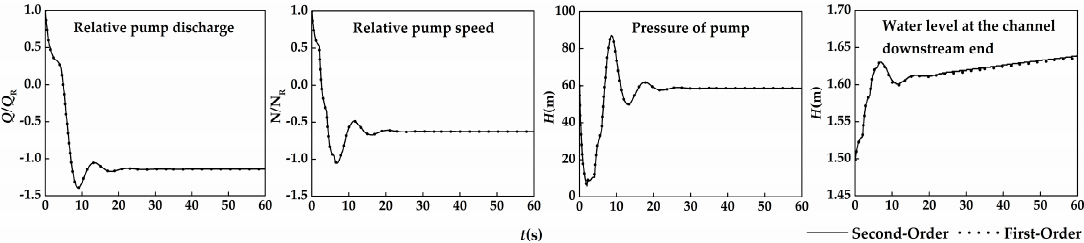
Figure 8. History curves of pump and channel parameters of First-order and second-order interpolations.